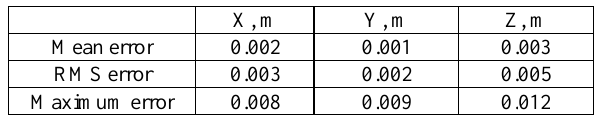
Table 1 . Accuracy estimation of point cloud registration Fig. 2 demonstrates the result of point cloud registration